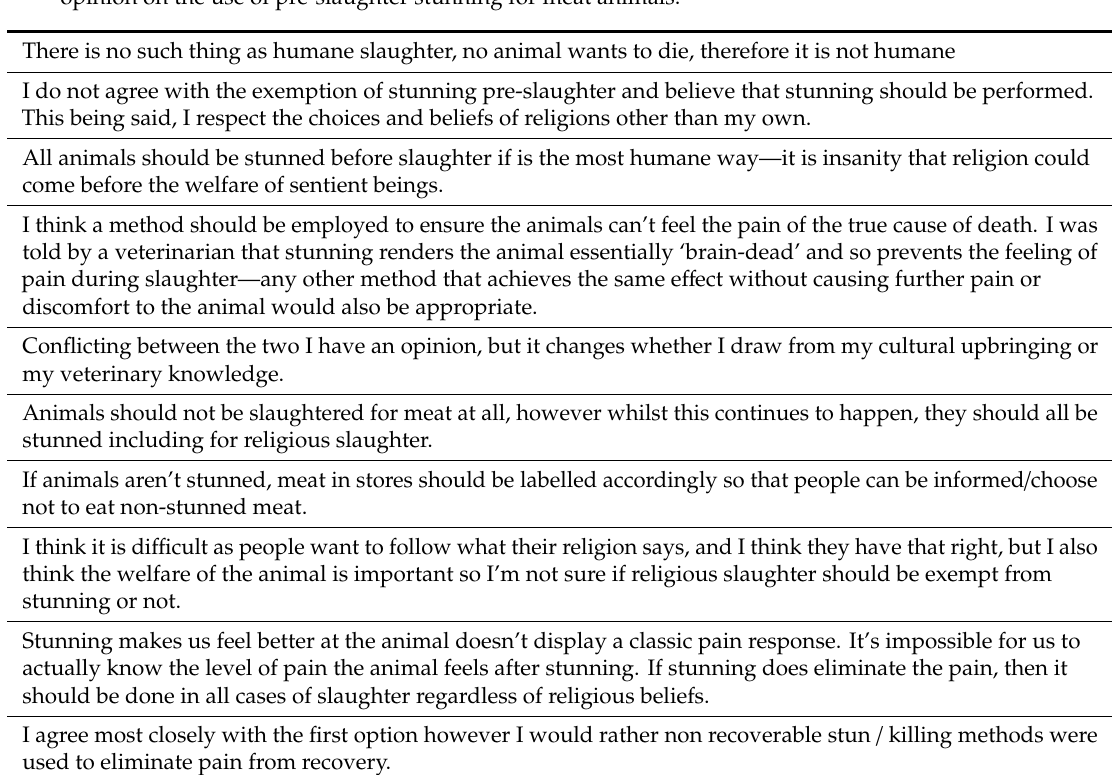
Table 3. Cross tabulation of the year of study of respondent and willingness to buy and consume Halal meat derived from animals that have been stunned before